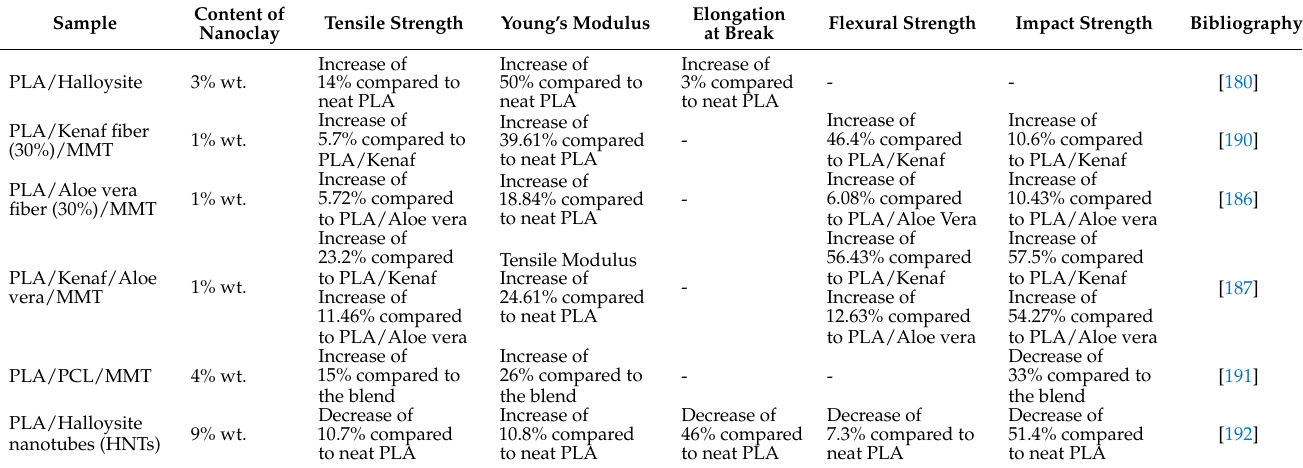
Table 3. PLA/nanoclays composites and their mechanical properties as found in the